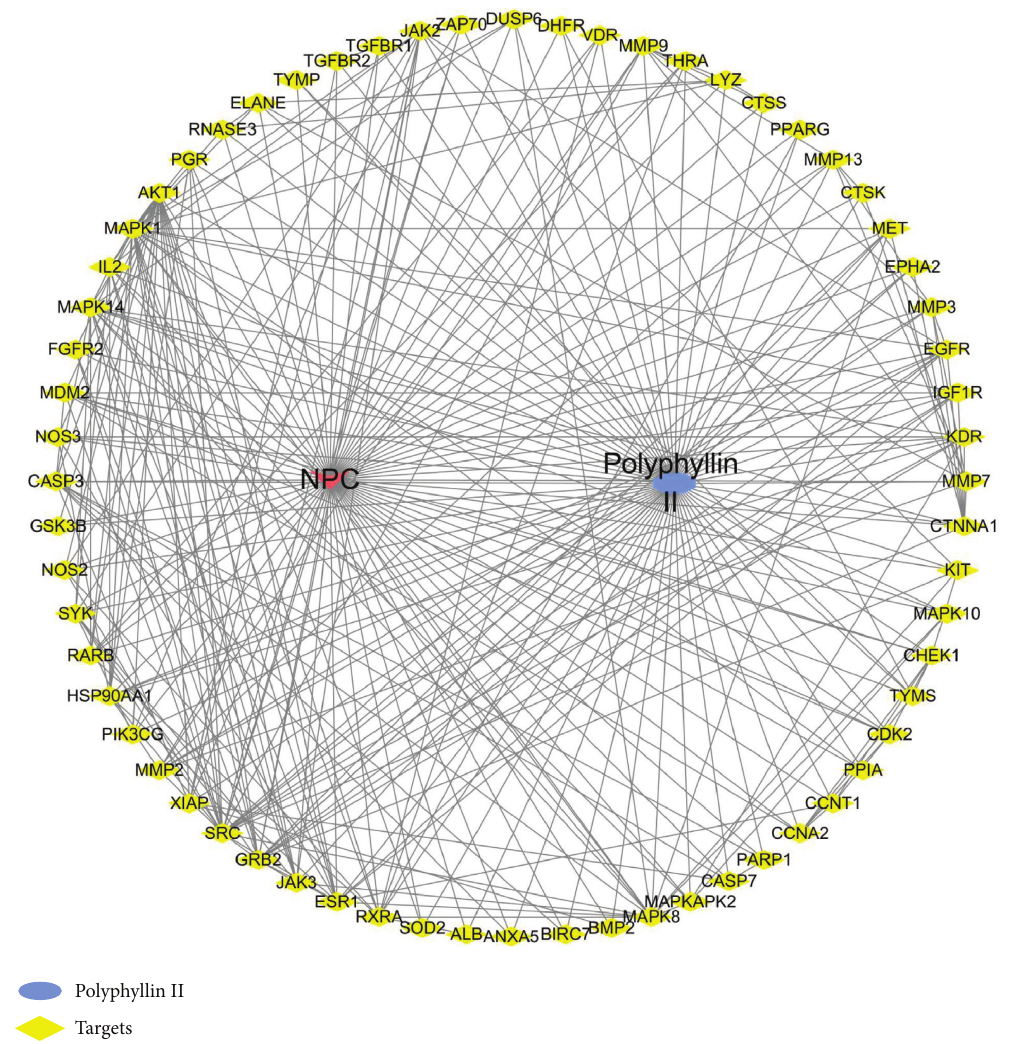
Figure 9: “Drug-target-disease” network